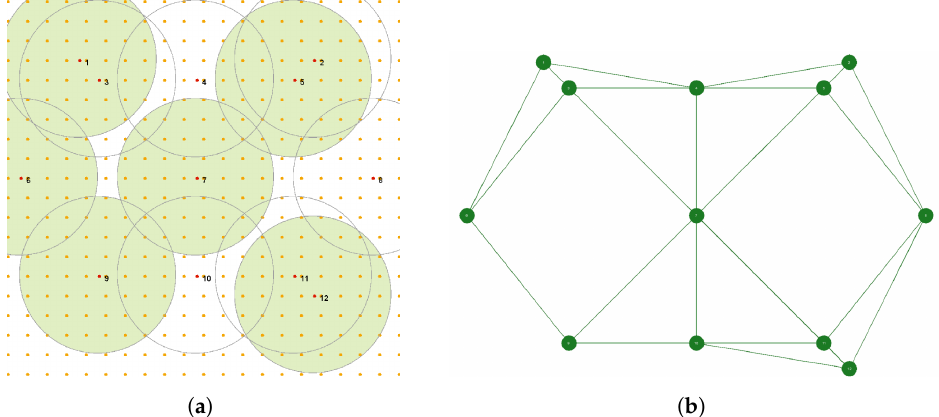
Figure 1. Example of a monitored area containing 441 PoI with WSN 12 consisting of 12 sensors with R s = 20 m ( a ); corresponding WSN graph for WSN 12 ( b